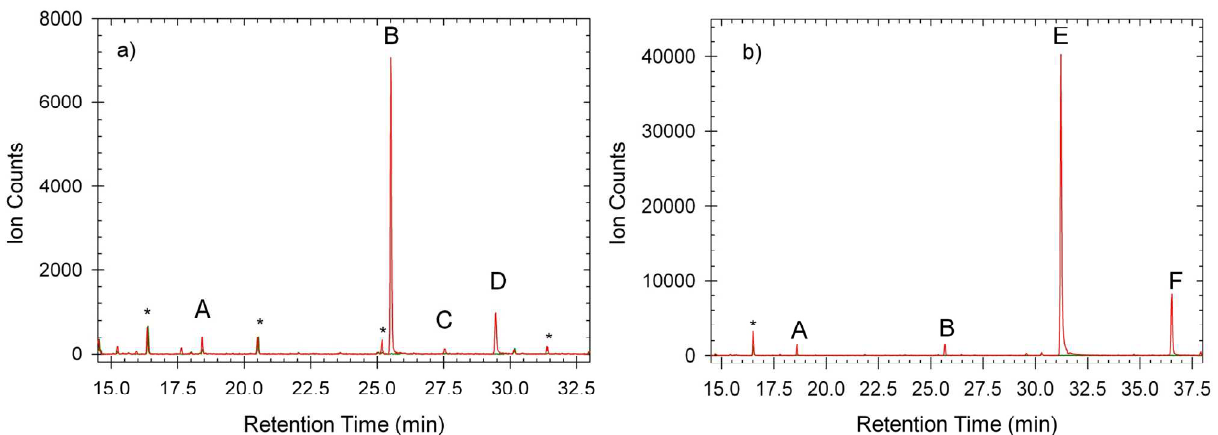
F IGURE 3. Chromatograms from derivatized samples of a) headspace sample from male P. thurberi ) and whole flower P. thurberi , showing ions m/z 179 and 236. Letters correspond to putative identifications listed in Table 2. Floral samples shown in red and derivatized hexane blank in green. Peaks marked by * are contaminants due to the extraction